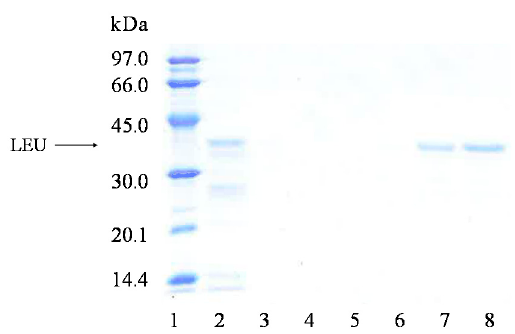
Figure 6. SDS-PAGE analysis of octyl-VS-CALA-PEI-LEU after incubation and washing with solutions having di ff erent concentrations of ammonium sulfate (AS). Lane 1: Low weight molecular markers; Lane 2: initial preparation; Lane 3: after incubation in 0.1 M AS; Lane 4: after incubation in 0.25 M AS; Lane 5: after incubation in 0.5 M AS; Lane 6: after incubation in 1.0 M AS; Lane 7: after incubation in 2.0 M AS and Lane 8: after incubation in 4.0 M AS. Other specifications are described in Methods.